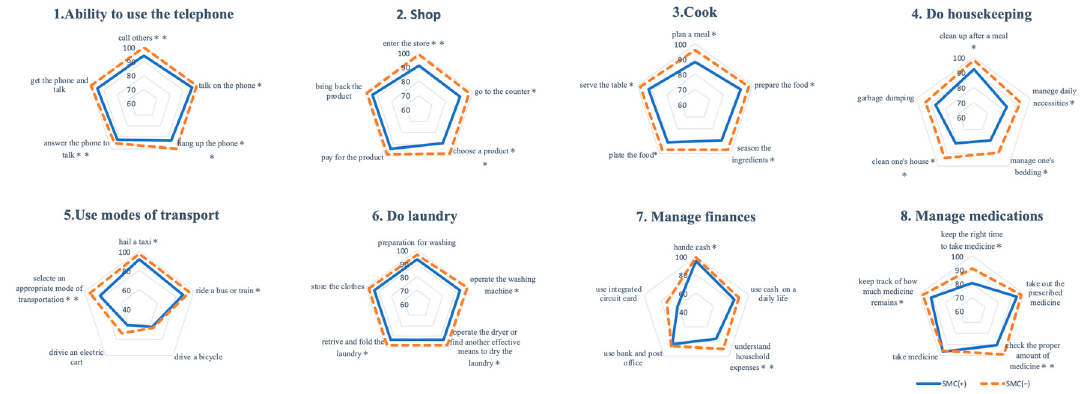
Figure 1. Comparison of independence of instrumental activities of daily living (IADL) process between with and without Subjective memory complaints (SMCs). The result of the Chi-square test of PADA-D 5 process for the two groups. Solid line; SMC ( + ) group, dotted line; SMC ( − ) group. * p < 0.05, ** p < 0.01.